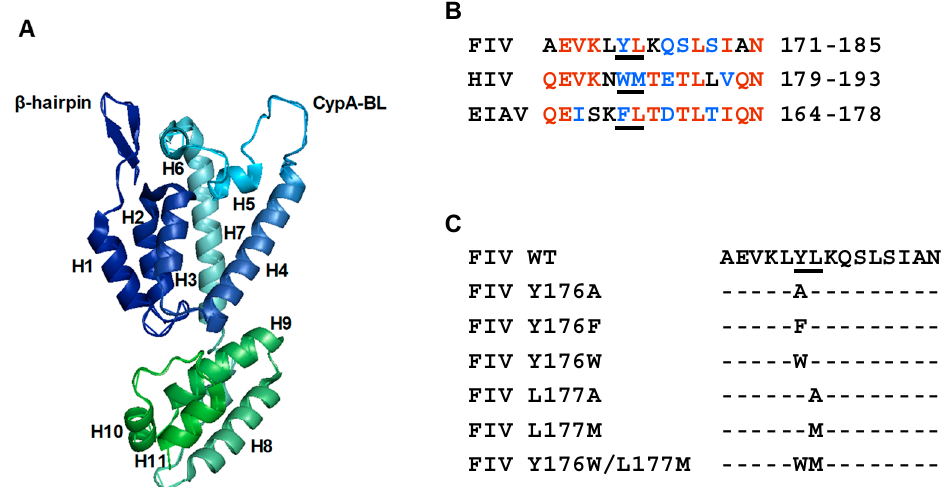
Figure 1. Mutagenesis of the Y176 and L177 residues in helix 9 of the FIV CA protein. ( A ) Ribbon representation of the crystal structure of the FIV CA (PDB 5NA2). The α -helices H1–H7 and H8–H11, corresponding to the N-terminal domain (CA-NTD) and C-terminal domain (CA-CTD), respectively, are shown. The N-terminal β -hairpin and the cyclophilin A-binding loop (CypA-BL) are also indicated. ( B ) Alignment of the amino acid sequences of helix 9 of FIV [33], human immunodeficiency virus type 1 (HIV-1) [51], and equine infectious anemia virus (EIAV) [31] CA proteins. Identical amino acids at the same positions in two or three sequences are highlighted in red, whereas similar residues are indicated in blue. The assembly-relevant motif W184 / M185 of HIV-1 CA as well as the amino acids present at equivalent positions in the FIV and EIAV CA helix 9 are underlined. ( C ) Amino acid substitutions that were designed to modify the Y176 / L177 motif in the FIV CA. Below the sequence of the wild-type (WT) FIV CA helix 9, the amino acids replacing Y176, L177, or both residues of the motif are